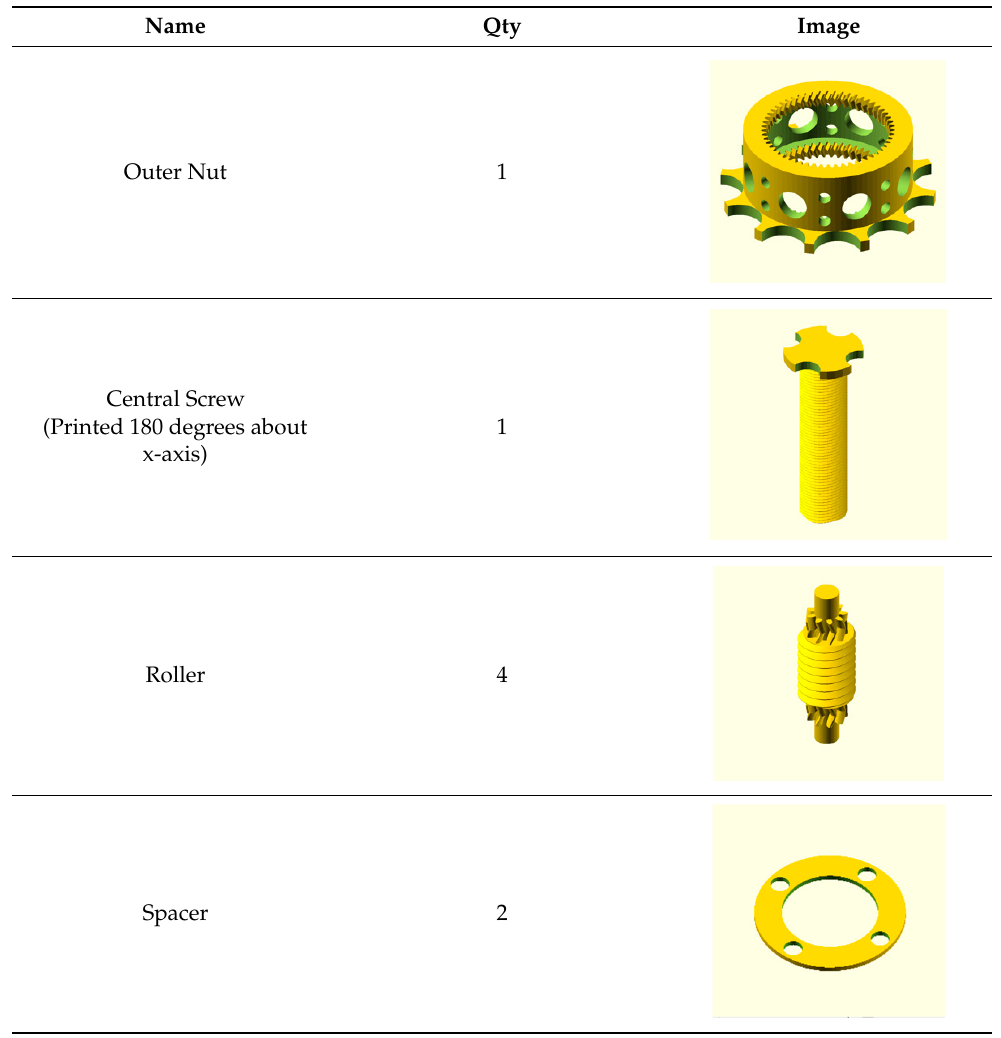
Table 4. BOM of roller screw assembly.